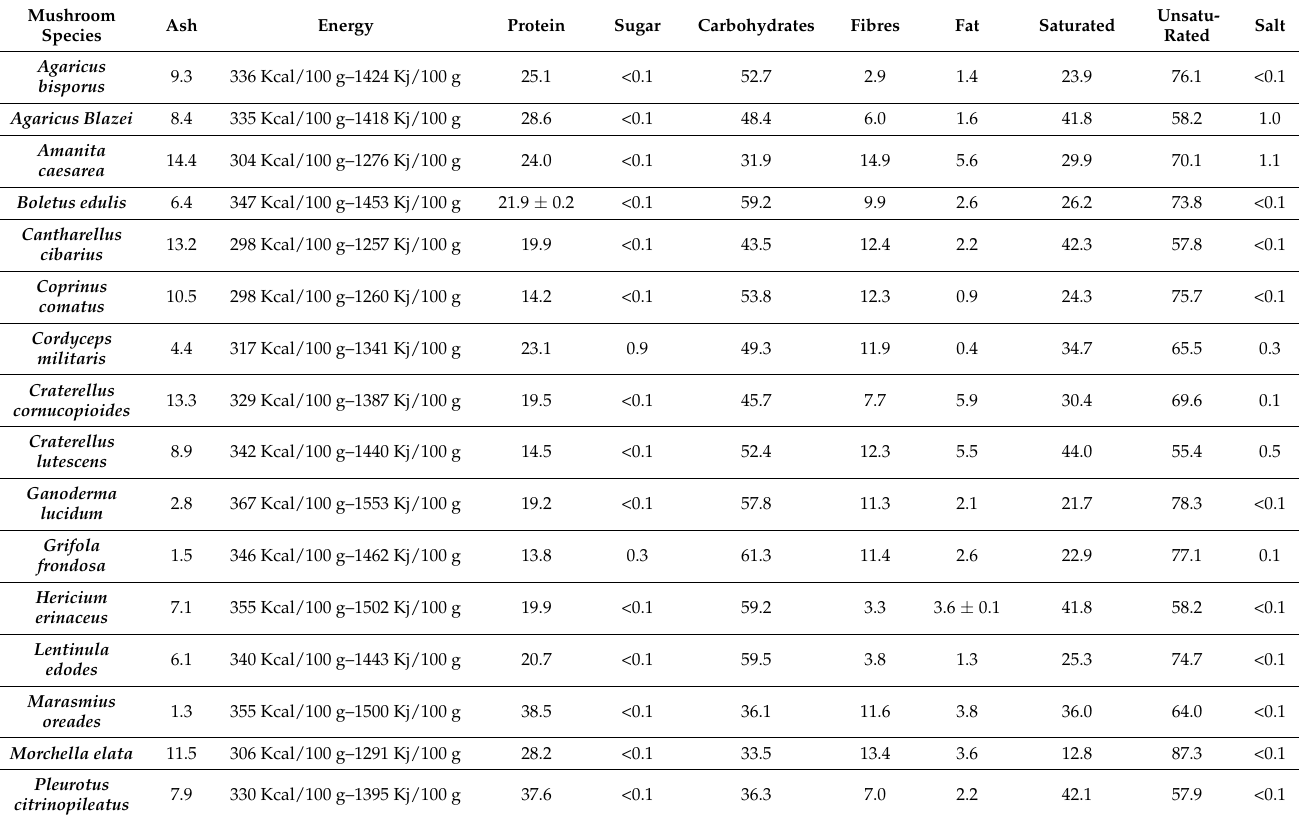
Table 1. Proximate analysis of edible mushrooms dry weight basis percent (TEI and University of Thessaly).